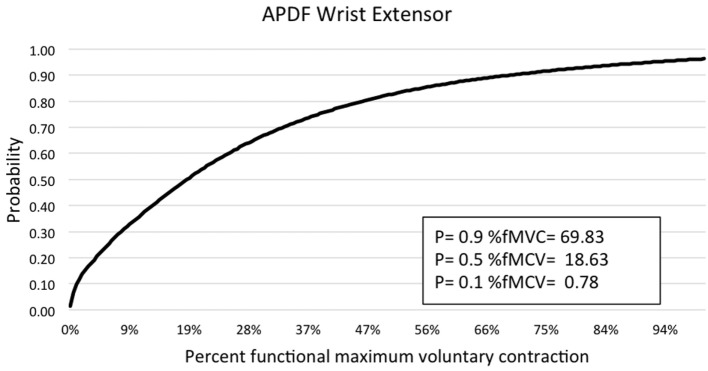
Graphic representation of typical APDF of the wrist extensors in the forearm.